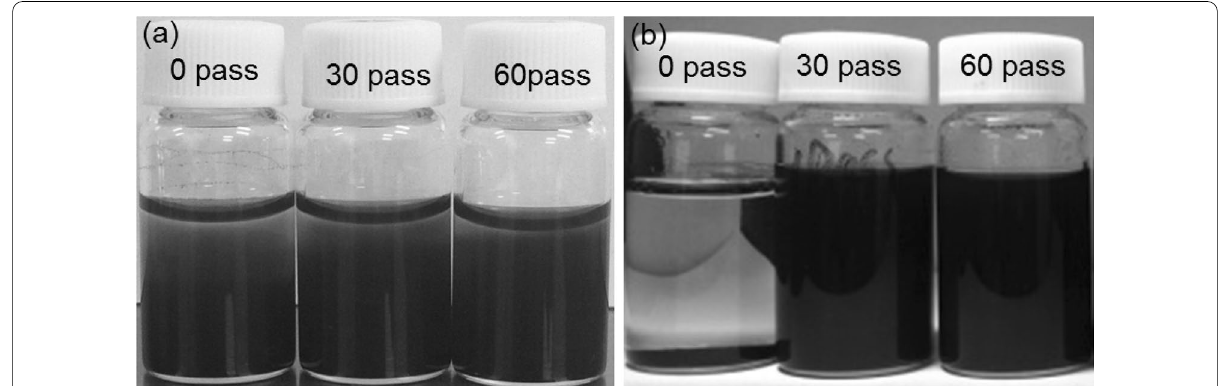
Fig. 7 Photographs of the 2-h- a and 8-h- b activated carbon dispersions prepared by aqueous counter collision (ACC) with 0, 30, and 60 passes, and left for 1